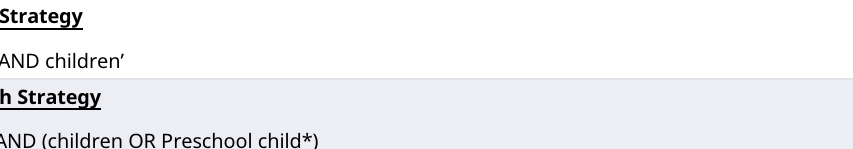
Table 2. Searching databases and